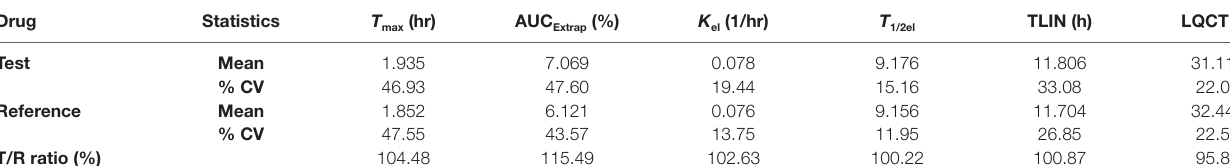
TABLE 10 | Secondary pharmacokinetic parameters for HCTZ after oral administration of single dose of test and reference tablets in human subjects ( n = 28). Drug